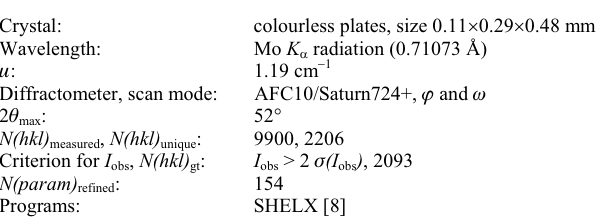
Table 2. Atomic coordinates and displacement parameters (in Å 2 )